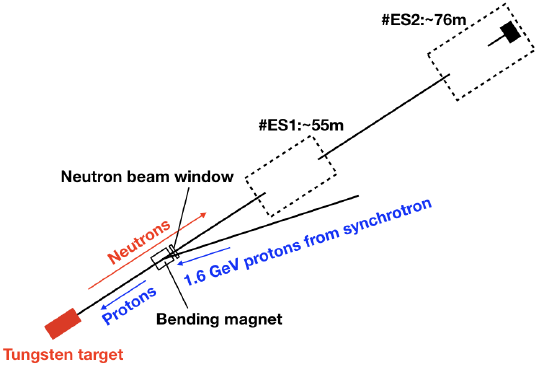
Figure 1: Layout of the Back-n beam line at CSNS.